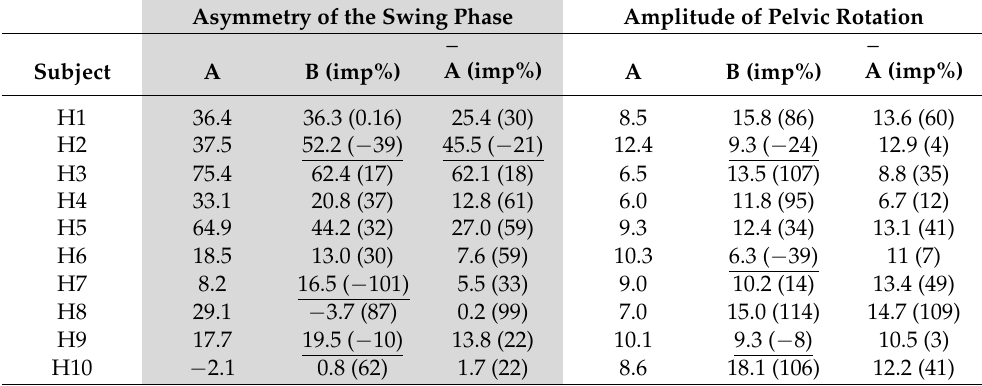
Table 6. Results of the experiments employing the modified intervention method.